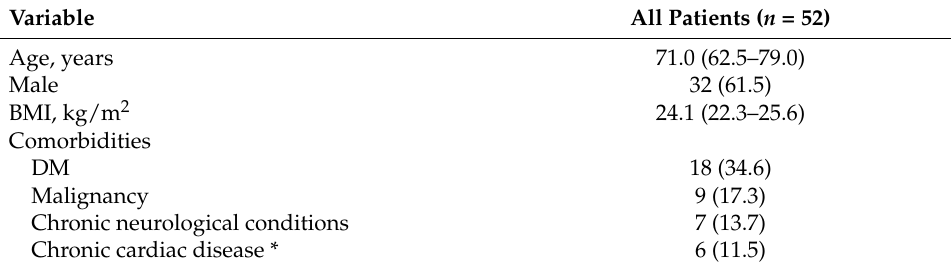
Table 1. The characteristics of the study